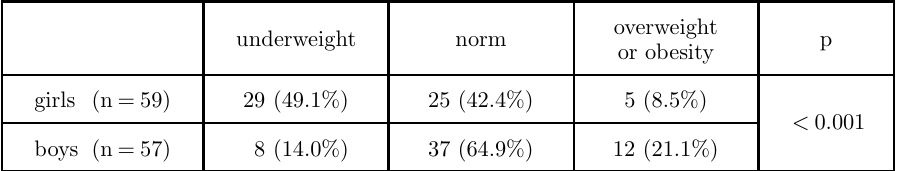
Table 1. BMI distribution for girls and boys underweight norm p girls (n = 59)